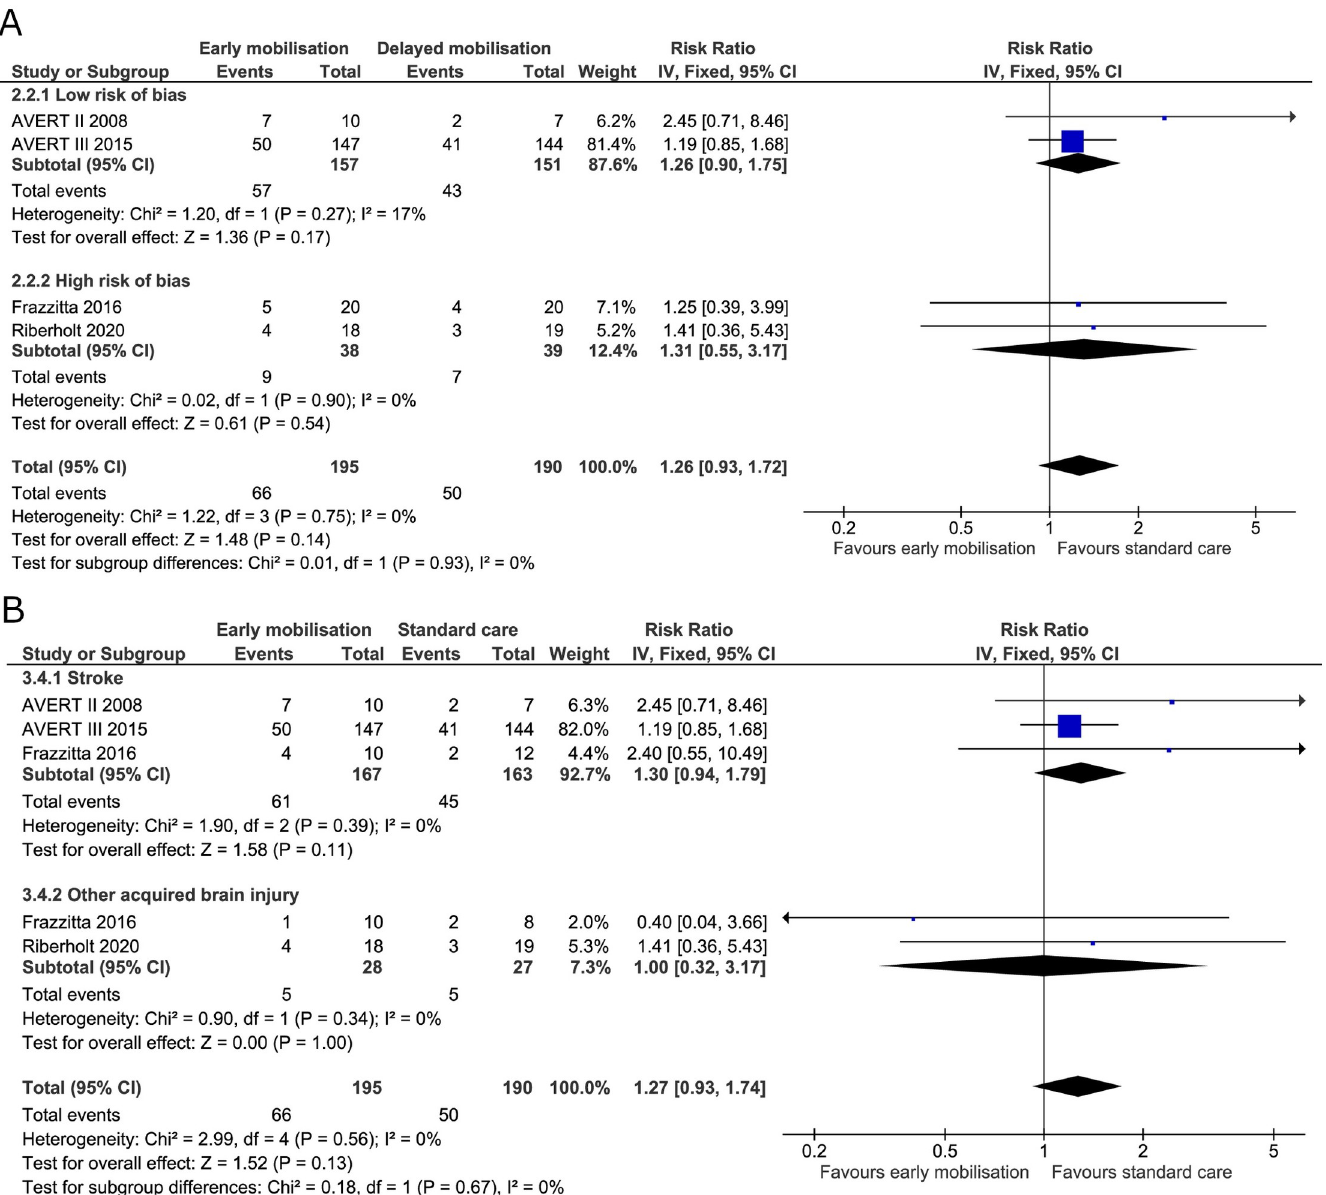
Fig 7. Comparison of early mobilisation versus standard care–mortality at maximal follow-up. Fig 7A and 7B. Forest-plots showing the results from the fixed-effect meta-analysis of the outcome mortality at maximal follow-up with subgroup divided according to risk of bias (A) or diagnosis (B).